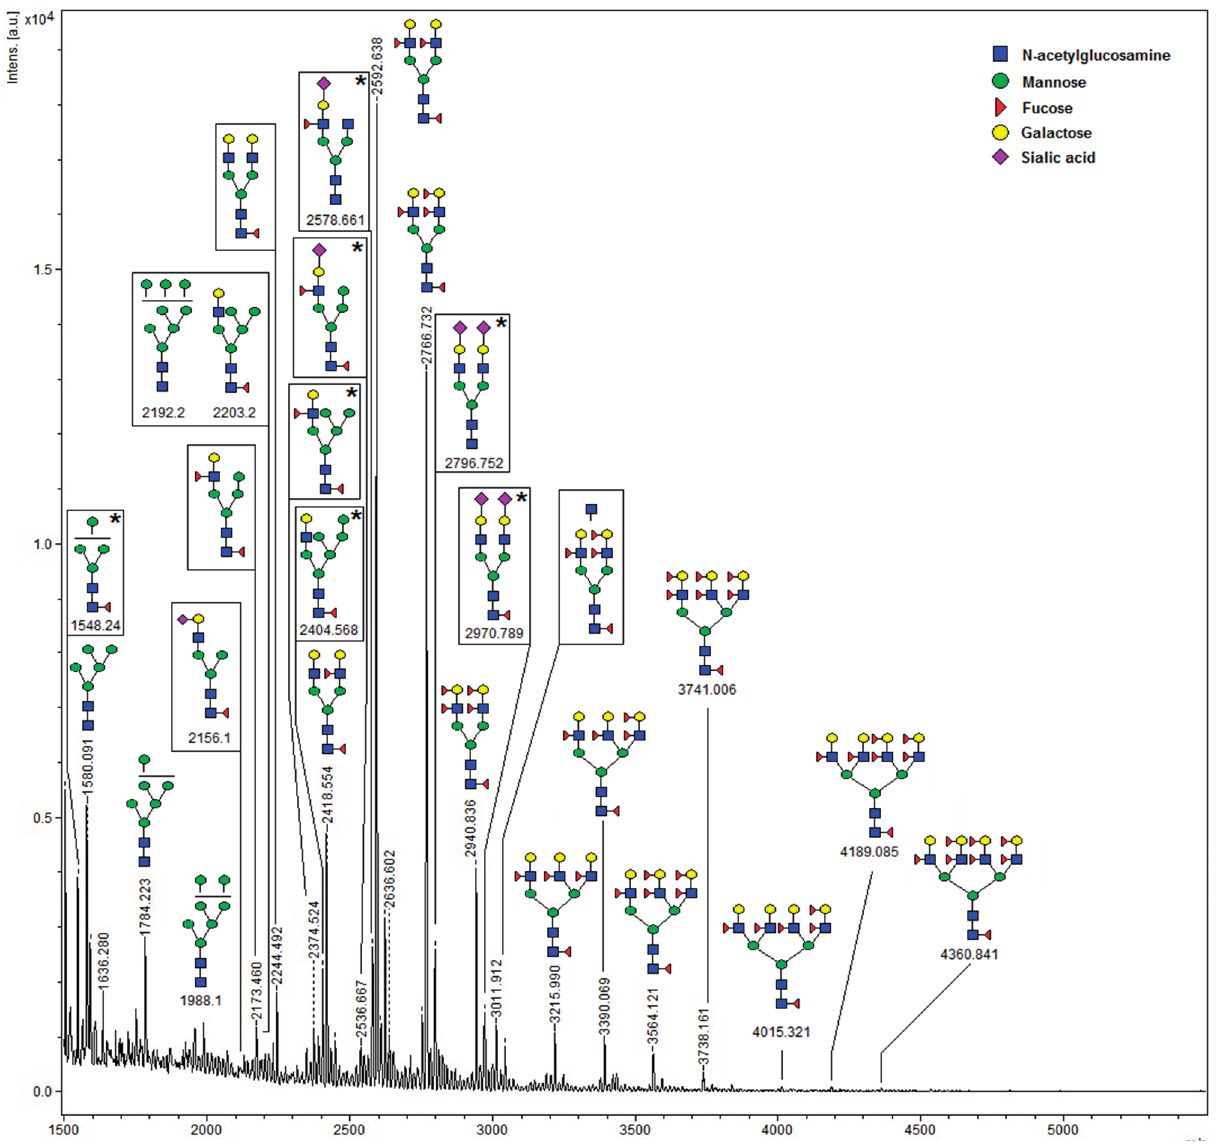
Figure 6. MALDI-TOF-MS profile of oligosaccharides isolated from GNL-reactive seminal plasma glycoproteins. * Structures not reported in